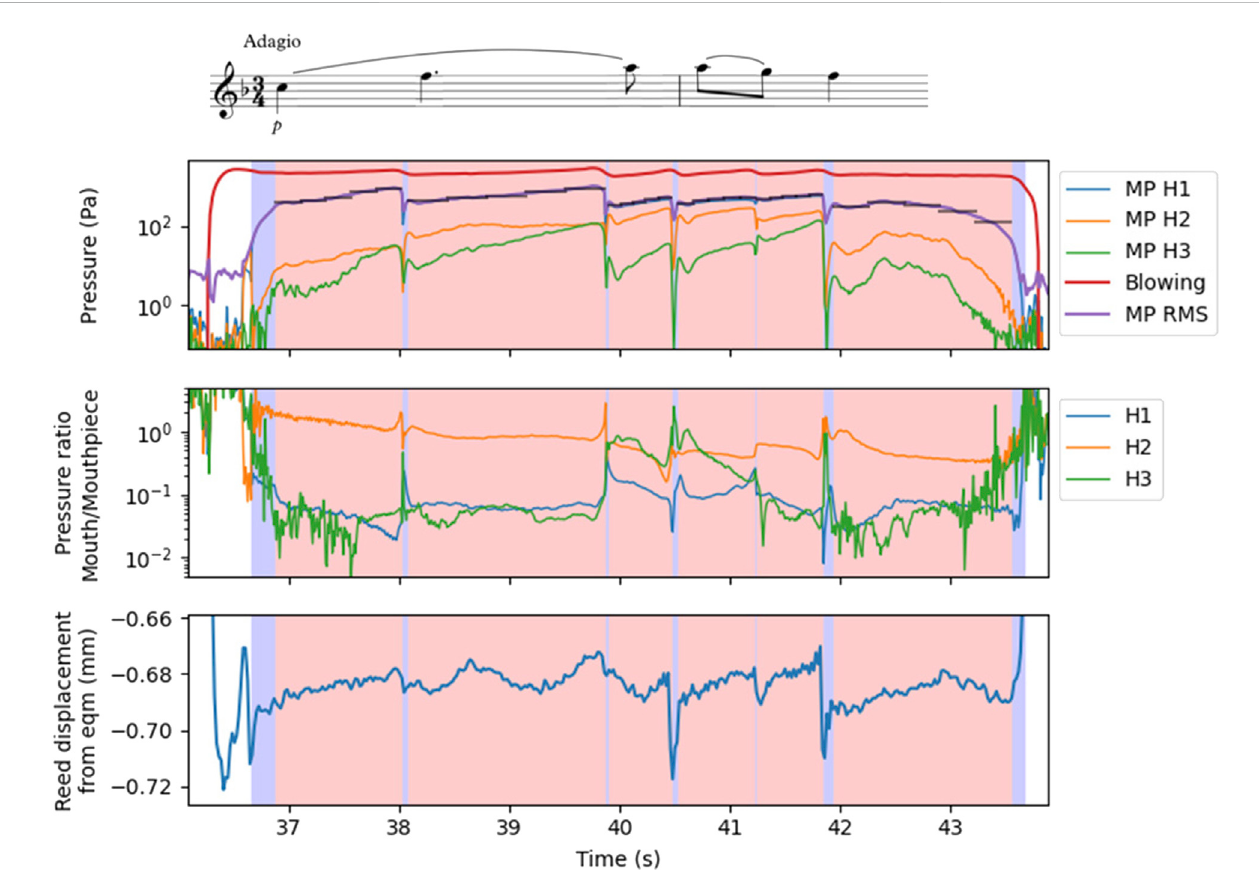
FIGURE 7 A 7-s sample from the applications section (Section 4), overlapping with the time period shown in Figure 6 on an expanded time scale showing six notes withsegmentationboundaries(includedinthewhiteregion),steadystateregioninredshading,and5-segmentenvelopesimpli fi cationforcharacterisationof each note. “ Blowing ” means the (DC or slowly varying) blowing pressure in the mouth, “ MP ” means mouthpiece, and H1 to H3 indicate fundamental and harmonics. Transient regions are marked as blue regions (see Figure